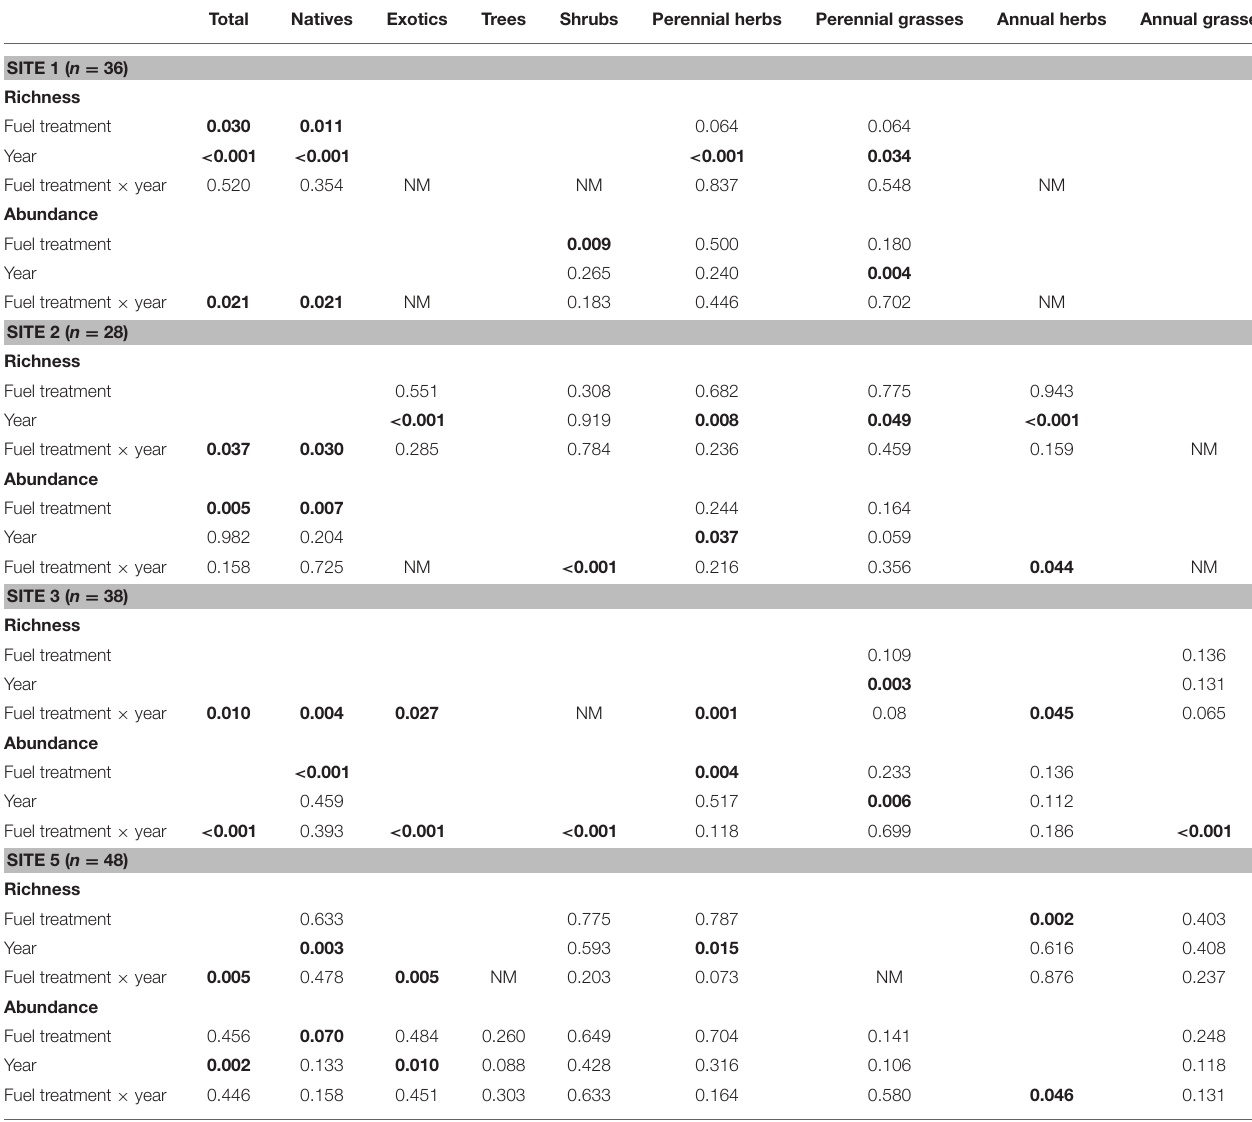
TABLE 3 | P -values for fuel treatment and year factors main effect, and their interaction for richness and abundance variables at each site. Total Natives Exotics Trees Shrubs Perennial herbs Perennial